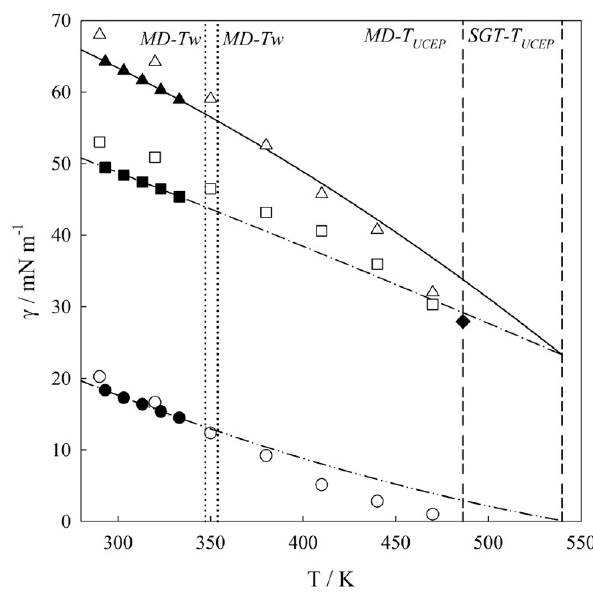
Figure 4. Interfacial tension, γ —temperature, T diagram for water (1) + n -hexane (2) mixture. Experimental data [11]: ( (cid:78) ) γ VL1 ; ( (cid:4) ) γ L1L2 ; ( • ) γ VL2 ; MD results: ( (cid:52) ) γ VL1 ; ( (cid:3) ) γ L1L2 ; ( ) γ VL2 ; SGT + SAFT-VR Mie EoS calculations: (—) γ VL1 ; (– • –) γ L1L2 ; (– •• –) γ VL2 . ( ••• ) Estimated wetting temperature (MD-T w = 347.20 K; SGT-T w = 353.81 K); (- - -) Estimated Upper Critical End Point (UCEP) temperature (MD-T UCEP = 486.30 K; SGT-T UCEP = 539.78 K). ( ) γ UCEP . Table 2. Interfacial tensions result from Molecular Dynamics for water (1) + n -hexane (2) along three-phase equilibrium a,b.